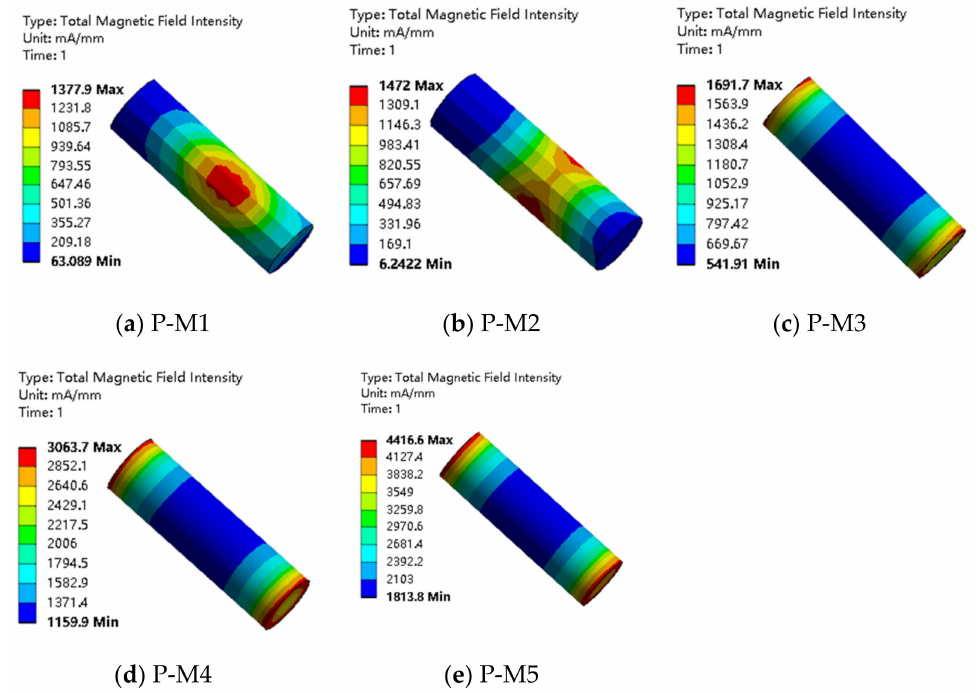
Figure 17. Magnetic field intensity distribution of Terfenol-D rod with five pre-magnetized